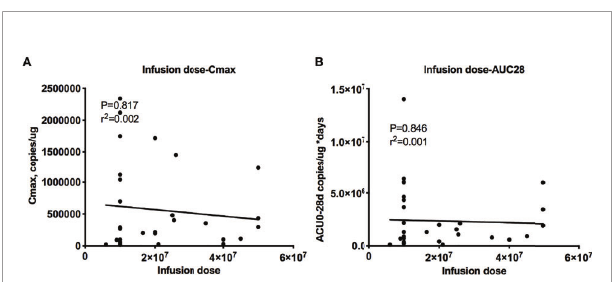
FIGURE 5 | Relationship between the dose and cellular kinetics. Relationships between the infusion dose and C max (A) and AUC 0 – 28 d (B) . The dose-exposure analysis showed a fl at relationship between the dose and cellular kinetic parameters, with r 2 = 0.004 for C max (A) and r 2 = 0.002 for AUC 0 – 28 d (B)